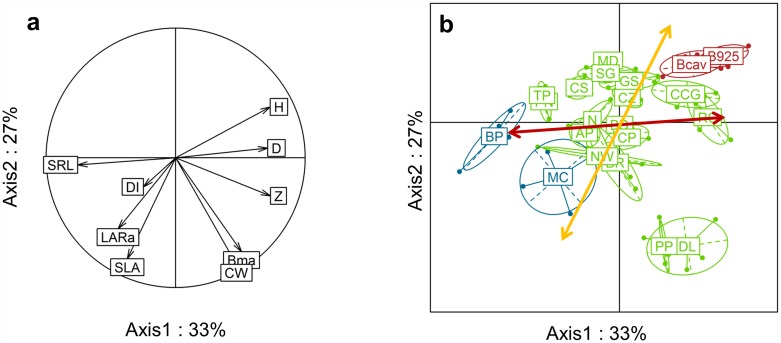
Principal component analysis on four soil-resource exploitation traits and six light exploitation traits and 21 species.a Correlation circle between traits; b Representation of weed species (in blue), banana cultivars (in red) and cover plant species (in green) on the first two axes (see Table 2 for the species names). The light exploitation traits are: Bma for aboveground dry biomass, SLA for specific leaf area, LARa for aboveground leaf area ratio, H for height and CW for plant crown width. The soil-resource exploitation traits are: SRL for specific root length, DI for total root-impact density, Z for the root exploration zone and D for root diameter. The yellow arrow represents the leaf economic spectrum gradient (according to the SLA direction) and the red arrow represents the root economic spectrum gradient (according to the SRL direction).